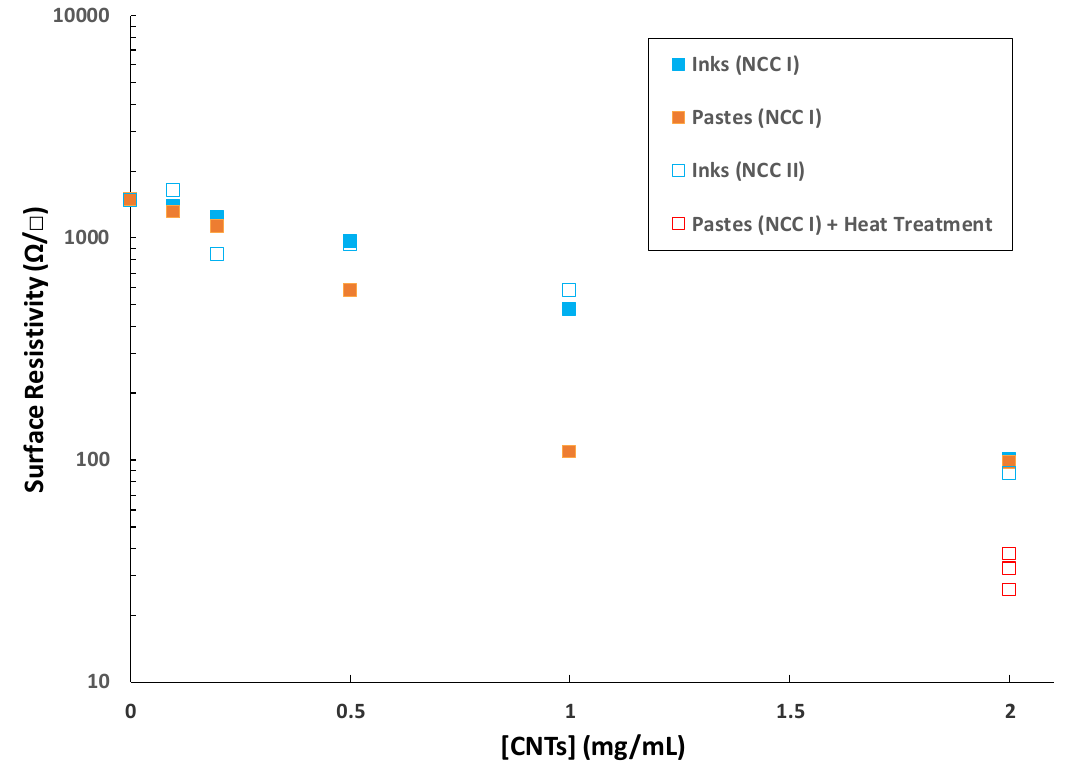
Figure 8. Surface resistivity measurements for different films prepared from inks and pastes. The concentration of CNTs refers to the one in the liquid formulation before deposition. All samples on this graph came from formulations with 2 mg/mL GO and 5 mg/mL NCC.